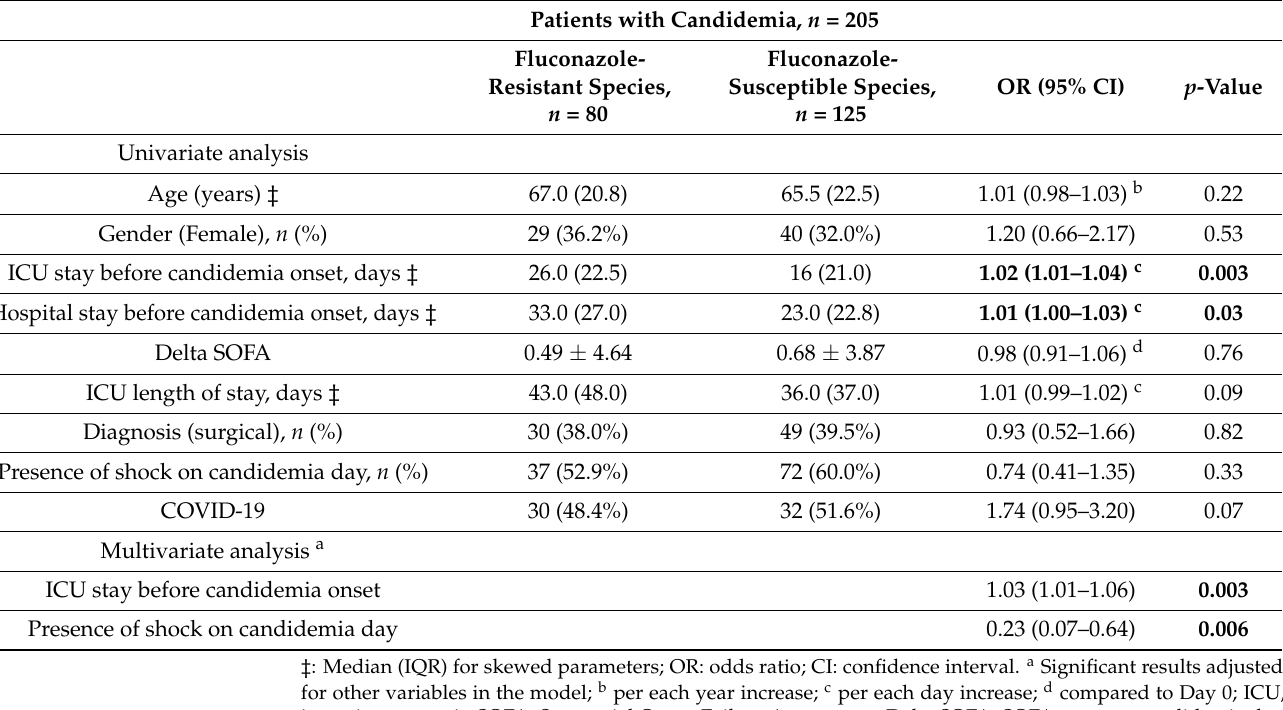
Table 4. Factors associated with candidemia development due to fluconazole-resistant Candida species in the overall patient population: univariate and multivariate models. OR (95% CI) takes fluconazole-susceptible as the reference